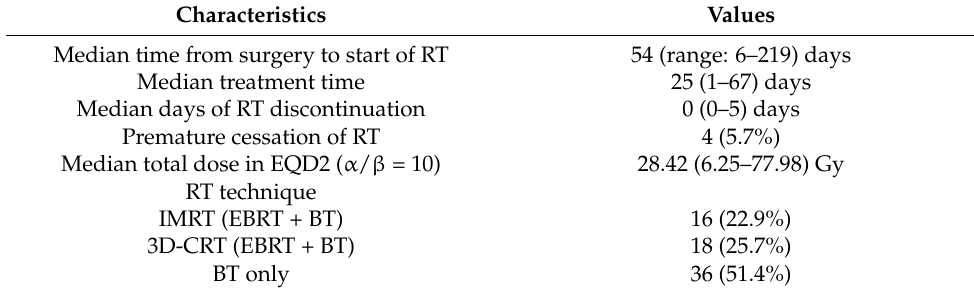
Table 2. Treatment